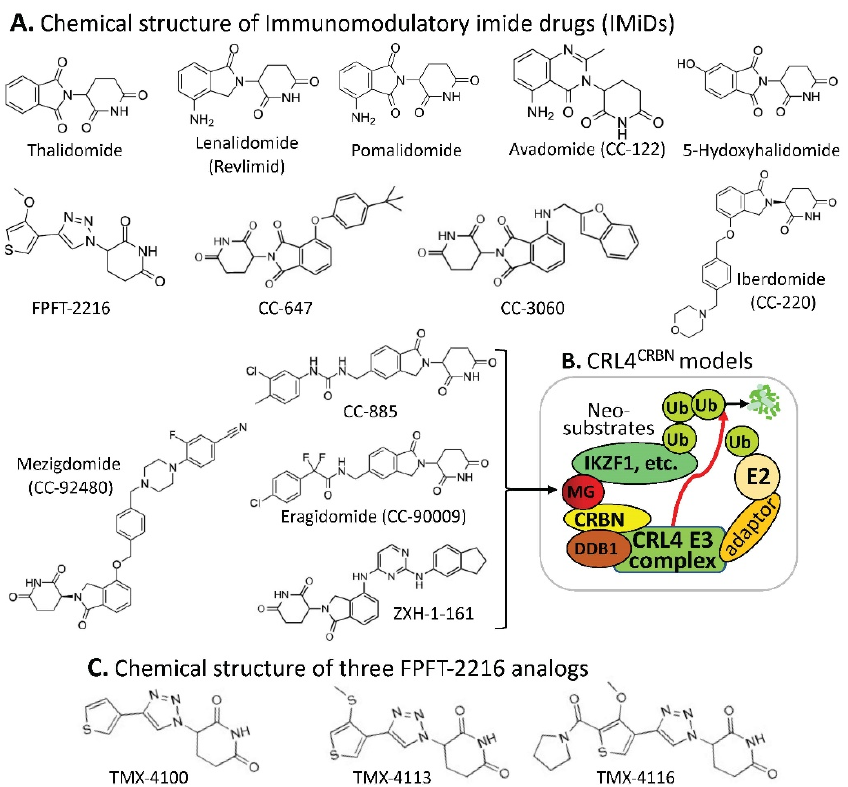
Figure 1. ( A ) The IMiD-type MG compounds’ chemical structures; ( B ) the substrate receptor CRBN- involved E3 ligase protein complex model. Each compound in ( A ) was documented to engage the same E3 ligase protein complex (CRL4 CRBN ) to polyubiquitinate the compound’s neosubstrates shown in Table 1. Then, the polyubiquitinated neosubstrates/protein targets in Table 1 would be degraded through the ubiquitination proteasome pathway; and ( C ) chemical structure of FPJFT-2216- derived three new small molecules (TMX-4100, TMX-4113, TMX-4116). Table 1. Relationship of MGs with their recruited protein substrates using CRL4 CRBN * .